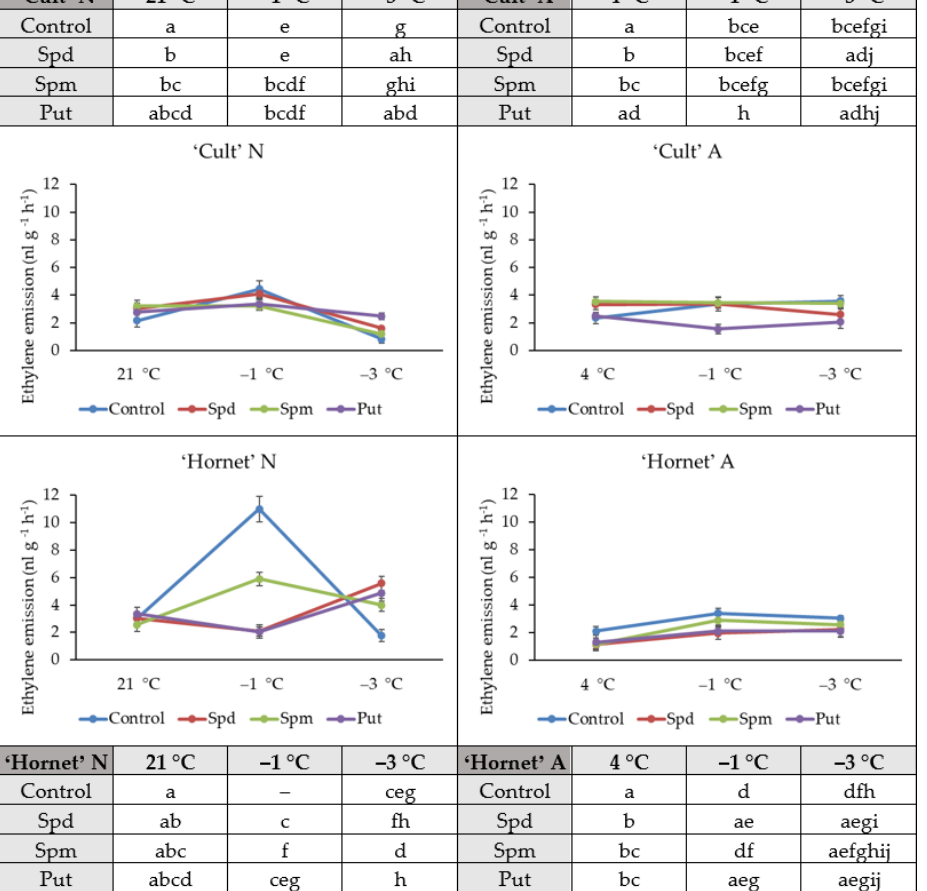
Figure 4. The effect of PA application, cold acclimation (4 °C, 4 days), and increasing cold treatment (from –1 to –3 °C, 2 days) on winter oilseed rape ethylene emission levels. Error bars represent the standard deviation of the mean. Control, Spd, Spm, and Put indicate the type of application. Capital letters N and A indicate non-acclimation and acclimation, respectively. Different lowercase letters indicate statistically significant difference ( P < 0.05).